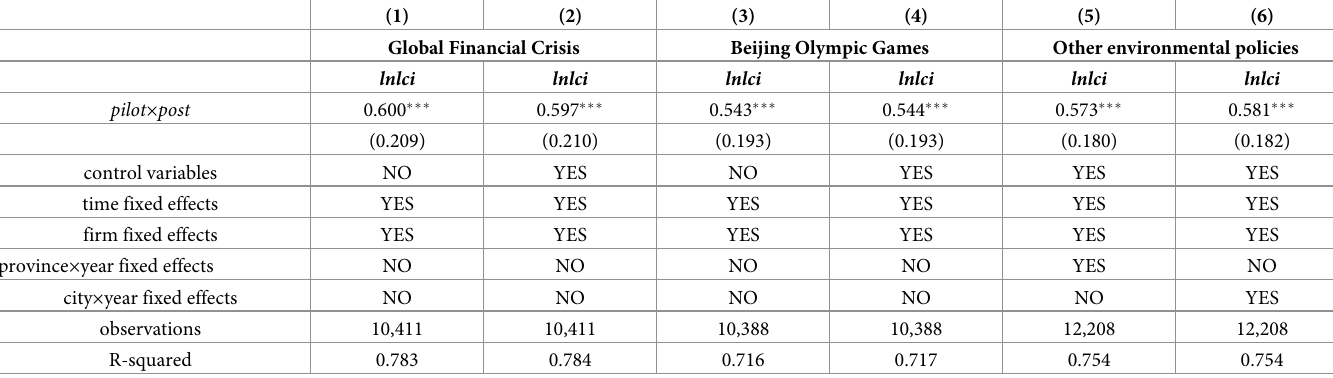
Table 4. Eliminating the impact of important